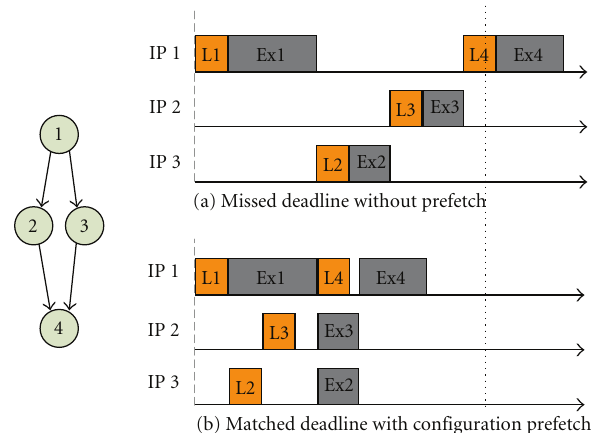
Figure 2: Principle of configuration prefetch for a graph of four tasks that execute on three cores denoted IP1 to IP3.